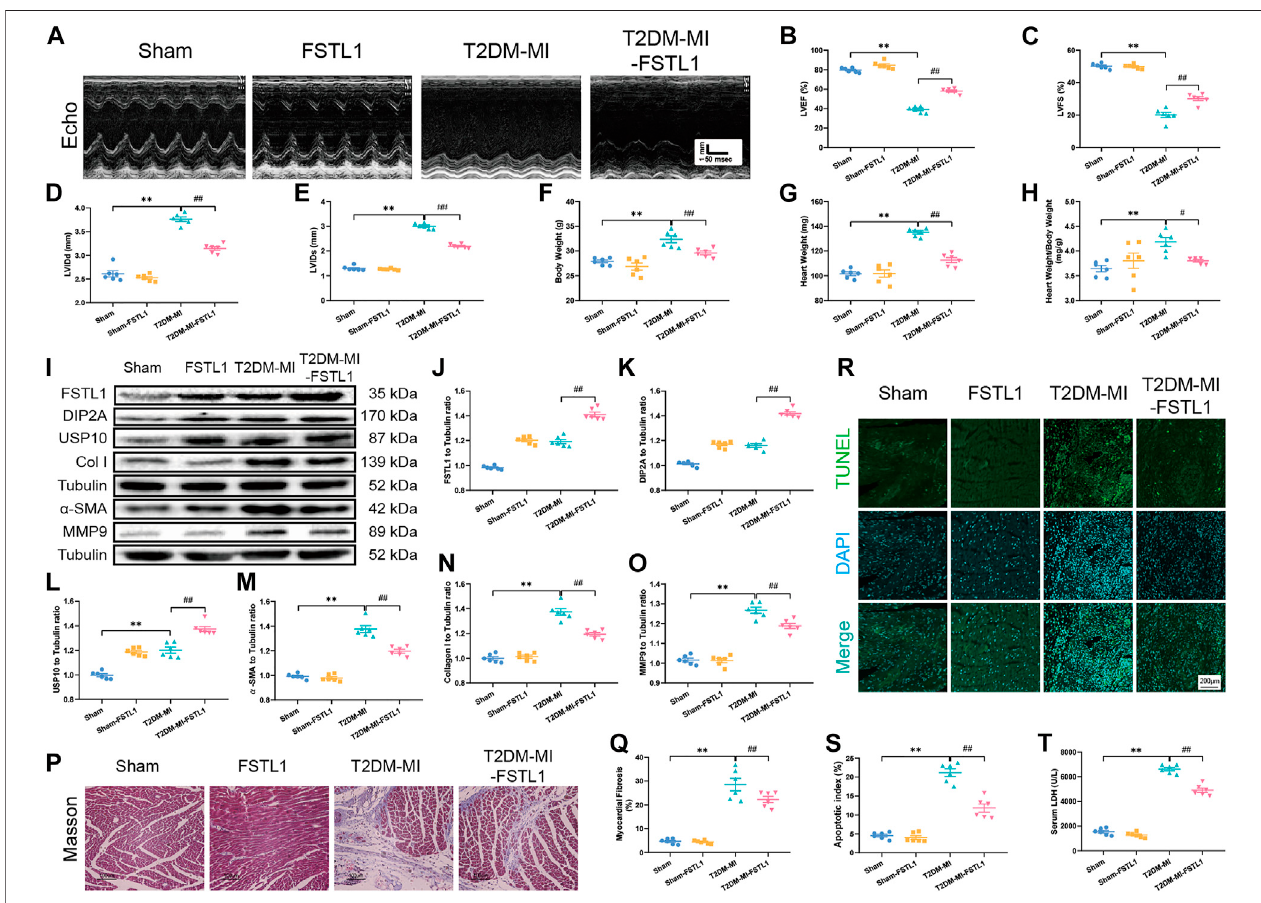
FIGURE 4 | The effect of FSTL1 treatment on heart function, myocardial fi brosis, apoptotic index, and serum LDH level in T2DM mice following MI injury. (A) Representative M-mode images of echocardiography challenged with MI injury in T2DM mice with/without FSTL1 treatment; (B) Left ventricular ejection fraction (LVEF); (C) Left ventricular fractional shortening (LVFS); (D) Left ventricular internal diameter at end-diastole (LVIDd); (E) Left ventricular internal diameter at end-systole (LVIDs); (F) Bodyweight; (G) Heartweight; (H) Heart weighttobodyweightratio; (I) Representativeimages ofWesternblotinT2DMmicechallenged withshamorMIinjury with/withoutFSTL1treatment; (J) FSTL1level; (K) DIP2Alevel; (L) USP10level; (M) α -SMAlevel; (N) CollagenIlevel; (O) MMP9level; (P) Cardiacinterstitial fi brosisusing Masson ’ sTrichromestaining; (Q) Pooleddataoftheinterstitial fi broticareaofmyocardialtissues; (R) Representativeimagesofapoptoticcardiomyocytes.TUNEL:green fl uorescencerepresentsTUNELpositivenuclei;DAPI:blue fl uorescencerepresentstotalcardiomyocytenuclei; (S) Myocardialapoptosiswaspresentedastheapoptotic index( × 100%);and (T) SerumLDHlevel.Sham:micewereundergoingashamoperation;FSTL1:micewereundergoingashamoperationandintracardiacinjectedwith AAV9-FSTL1; T2DM-MI: HFD induced T2DM mice underwent MI surgery and intracardiac injected with AAV9-NC; T2DM-MI-FSTL1: HFD induced T2DM mice underwent MI surgery and intracardiac injected with AAV9-FSTL1. The results are presented as Mean ± SEM, n (cid:2) 6 in each group. ** p < 0.01. Scale bar in (Q) was 100 μ m and the scale bar in (R) was 200 μ